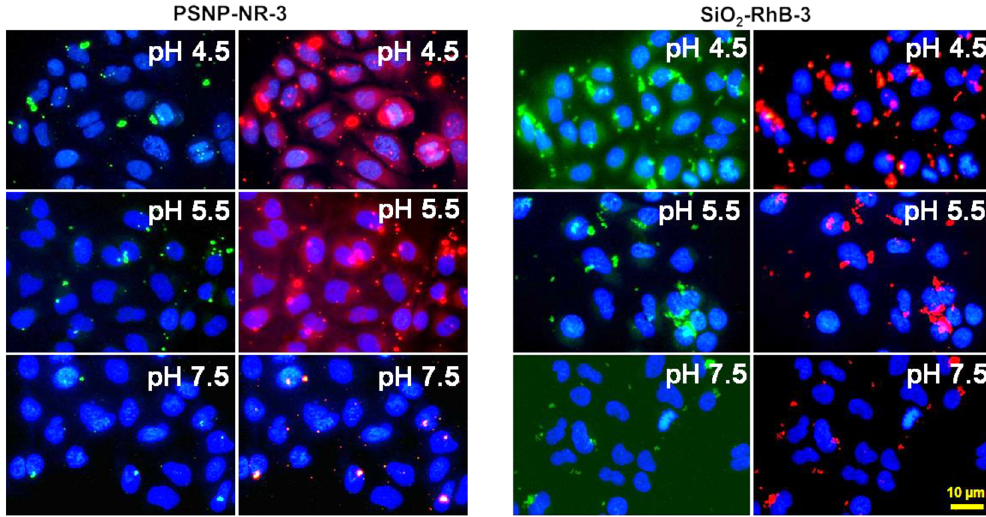
Figure 8. Epifluorescence images of fixed A549 cells incubated with solutions of pH nanosensors PSNP-NR- 3 , and SiO 2 -RhB- 3 in the presence of the ionophore nigericin for 30 min at different pH values; co-staining with DAPI, fixation with PFA. Excitation was carried out with an Osram 50 W/ACL1 Cz HBO Mercury vapor short- arc lamp and the fluorescence was monitored with emission filters set to λ Em = 470 nm (green channel) and to λ Em = 560 nm (red channel). For the detection of the fluorescence of DAPI Leica filter cube A (λ Em = 340/380 nm (blue channel) was used. All images show a scale bar of 10 µm. For all images the autofluorescence of the cells was subtracted by using images of a control measurement done under identical conditions without the addition of